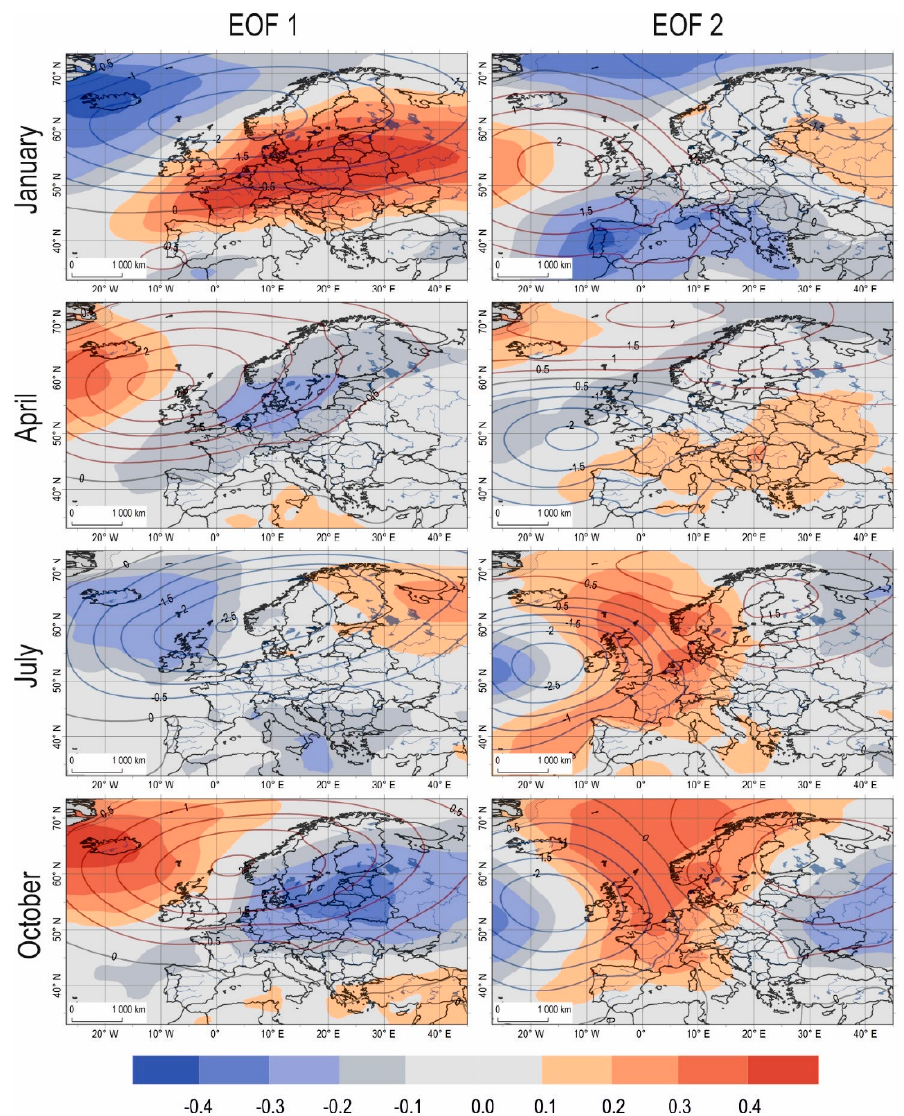
Figure 7. Spatial patterns of sea level pressure value (SLP) anomalies (hPa, solid lines) for two leading EOF modes and their relationship with TCWV (Pearson’s correlation coefficient, in color) in selected months (1981–2015).